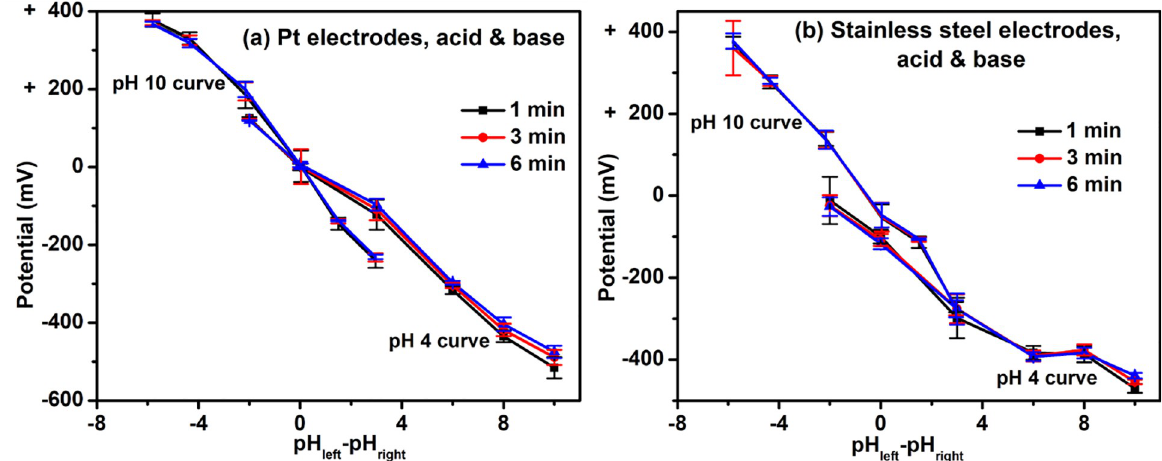
Fig 3. Potential difference between acids and bases. Solutions of various pH values were prepared by adding varied amounts of DI water to concentrated HCl or 1 M NaOH. For the experiments at reference value of pH 4, solutions of pH 4 in one beaker (right in Fig 1 ) were connected to the negative terminal of the voltmeter, while solutions with various pH values (i.e., 2, 4, 7, 10, 12, and 14) were added to the left beaker, which was in turn connected to the positive terminal of the voltmeter. Similarly, for experiments at pH 10, the solutions in the right beaker were maintained at pH 10. The pH left − pH right indicates the pH value of the solution in the left beaker minus the pH value of the solution in the right beaker. For example, when the pH of the solution in the left beaker was 12, and the pH of the solution in the right beaker was 10, the pH left − pH right was 12 minus 10, or